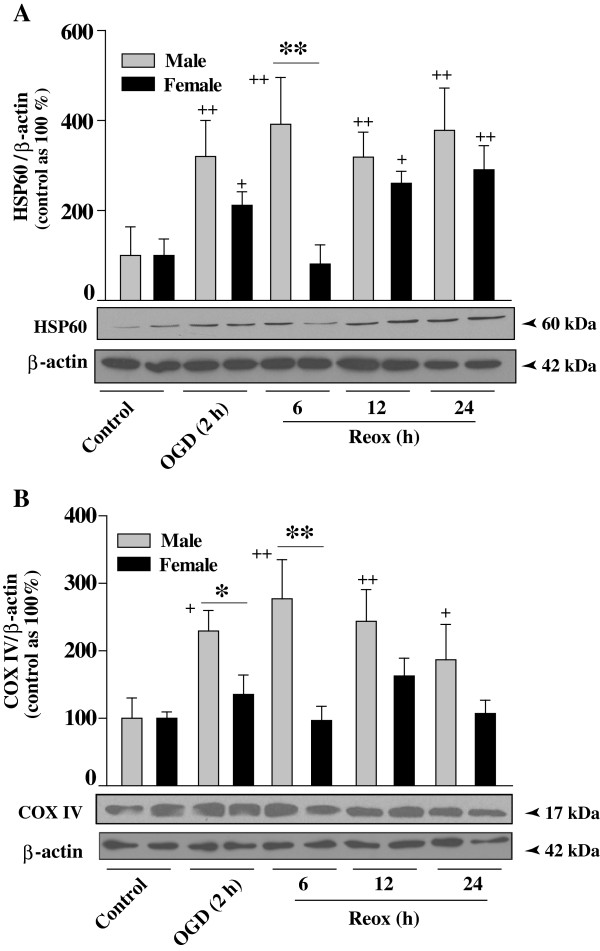
Expression of HSP60 and COX IV proteins in XY and XX neurons upon exposure to OGD followed by reoxygenation for indicated times. Western immunoblotting for HSP60 (60 kDa) and COX IV (17 kDa) were performed using total cellular extracts prepared from normoxia and OGD reoxygenation exposed XY and XX CGN cultures. Blots were restriped and immuno-labeled for β-actin, which also served as loading control. An increased expression of (A) HSP60 and (B) COX IV were observed in XY as compared to XX CGNs. Results are mean ± SD (n = 3, *p < 0.05, **p < 0.01, XY vs. XX; +p < 0.05, ++p < 0.01 vs. control, ANOVA followed by Bonferroni/Dunn post hoc test).